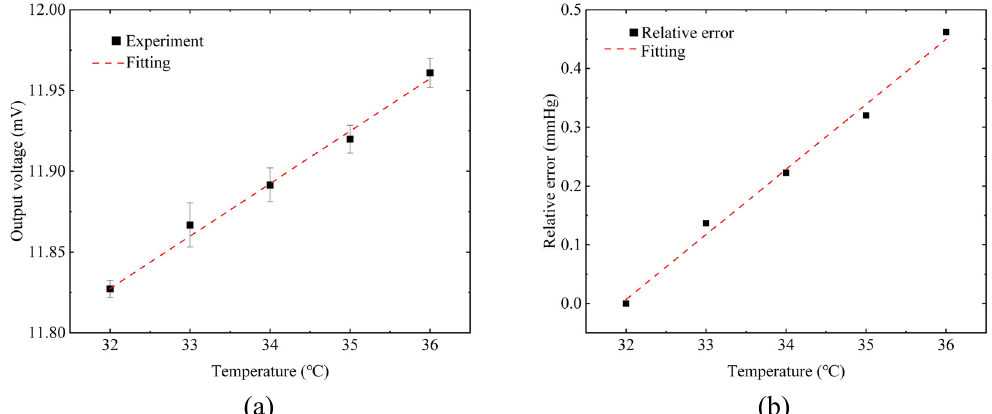
Figure 7. ( a ) Changes in the sensor’s output voltage when the temperature increases from 32 °C to 36 °C. ( b ) Related measurement error when the temperature increases from 32 °C to 36 °C.